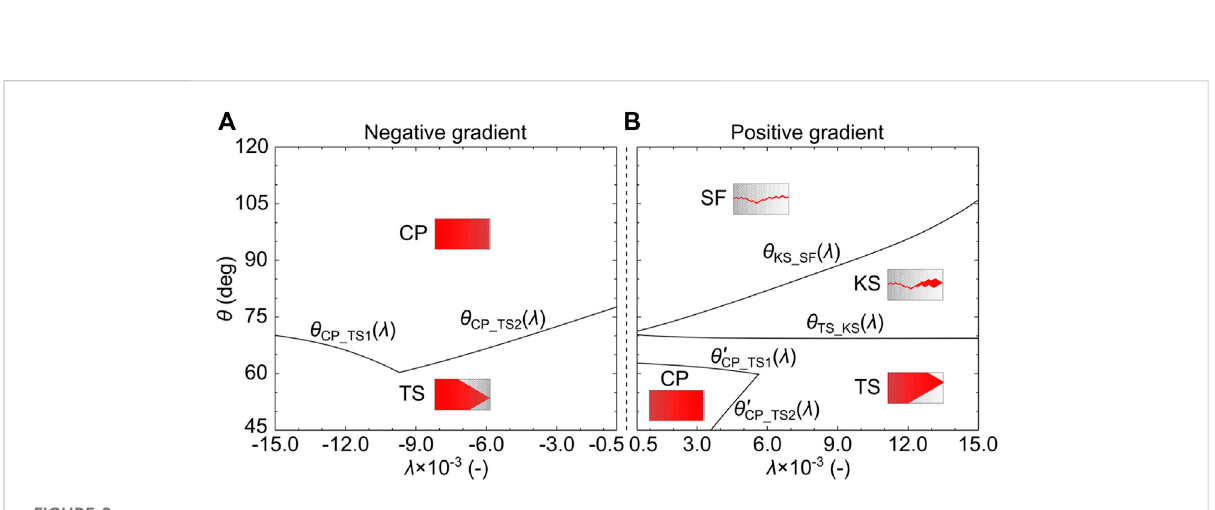
FIGURE 8 Phase diagram of displacement patterns in the λ - θ plane with λ ranging from − 1.5 × 10 − 2 to − 5 × 10 − 4 in negative gradient porous media (a) and from 5 × 10 − 4 to 1.5 × 10 − 2 in positive gradient porous media (B) and with θ ranging from 45 ° to 120 ° . The black curves of θ CP_TS , θ TS_KS , and θ KS_SF are the boundary of CP, TS, KS, and SF and are determined by the theoretical model (Eqs 1 –